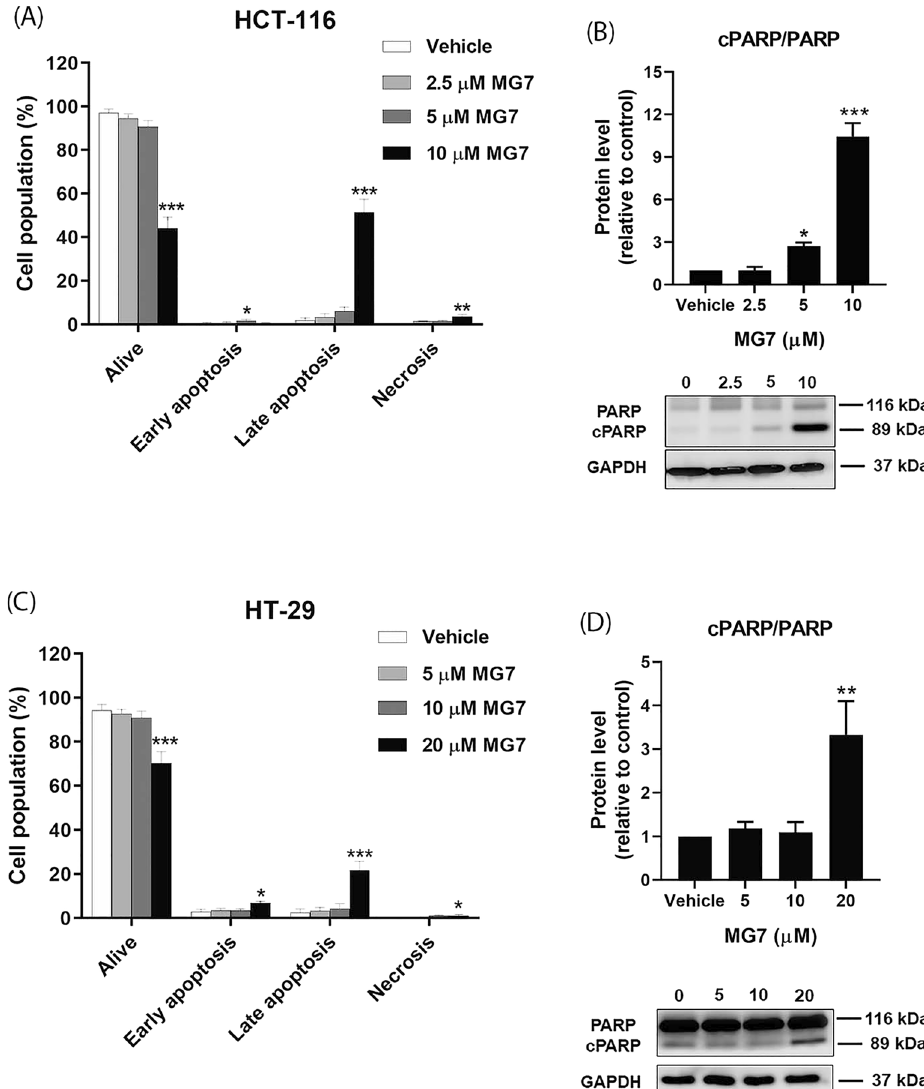
Figure 4. Effects of MG7 on apoptosis induction in CRC cells. ( A ) The percentages of apoptotic HCT-116 cells after being treated with MG7 at 2.5, 5 and 10 µM for 24 h were evaluated using annexin-V/PI staining followed by flow cytometry. ( B ) The expression ratio of cleaved PARP to total PARP proteins in HCT-116 cells was determined using western blot. ( C ) The percentage of apoptotic HT-29 cells and ( D ) the expression ratio of cleaved PARP to total proteins in HT-29 cells after being treated with MG7 at 5, 10 and 20 µM for 24 h. * P < 0.05, ** P < 0.01 and *** P < 0.001 compared to vehicle control (0.2%